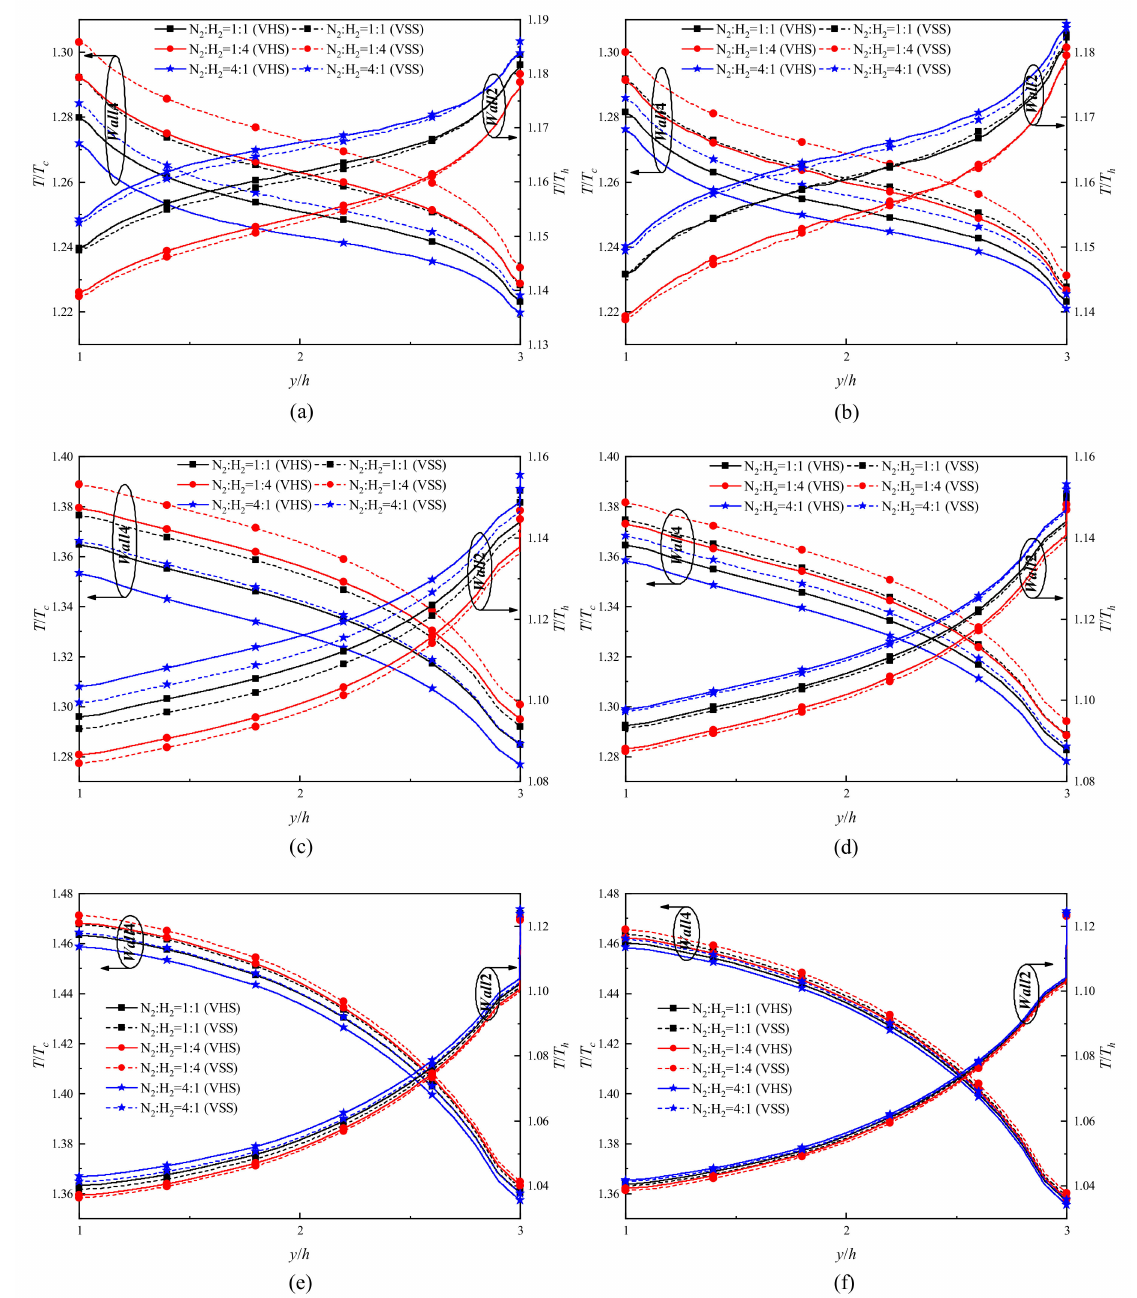
Figure 4. Temperature jump distributions of H 2 and N 2 on the Wall 2 and Wall 4 surfaces for di ff erent pressures. ( a ) P = 71.495 kPa, gas species: H 2 , ( b ) P = 71.495 kPa, gas species: N 2 , ( c ) P = 14.3 kPa, gas species: H 2 , ( d ) P = 14.3 kPa, gas species: N 2 , ( e ) P = 1.43 kPa, gas species: H 2 , ( f ) P = 1.43 kPa, gas species: N 2